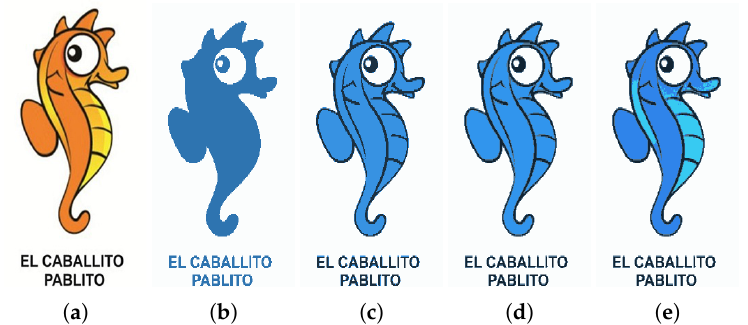
Figure 19. ( a ) Input image; ( b ) k = 2 clustering; ( c ) k = 3 clustering; ( d ) k = 4 clustering; ( e ) k = 5